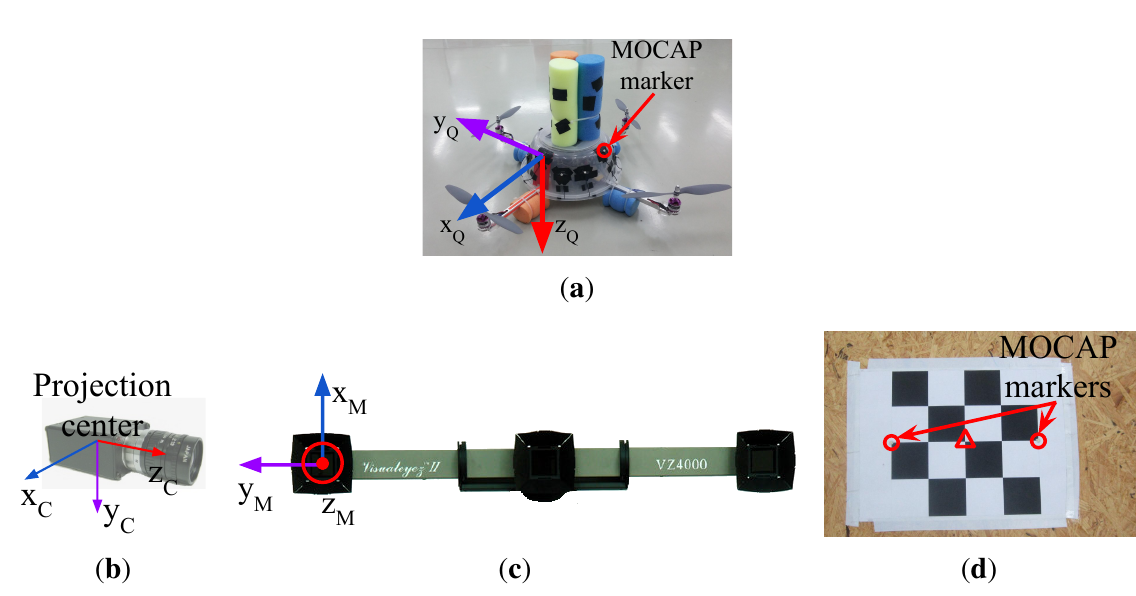
Figure 6. ( a ) The quadrotor used in our study and its body coordinate frame. There are 12 markers mounted roughly 30 ◦ apart from each other on the plastic cup of the quadrotor; ( b ) The body coordinate frame of the camera is defined at the projection center; ( c ) The TM Visualeyez II VZ4000 motion capture system and its body coordinate frame; ( d ) The calibration tool used to obtain 3D-2D correspondence points needed to estimate the transformation matrix, T C , between the motion capture system (MOCAP) and the camera M coordinate systems. Circles and the triangle indicate the MOCAP markers and the center of the chess pattern,